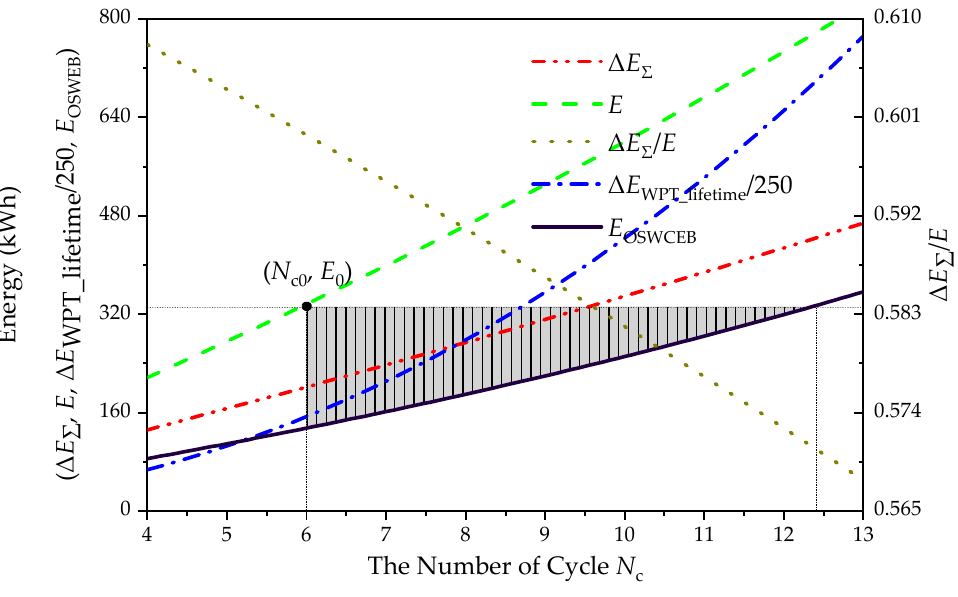
Figure 8. The effects of the number of cycles. Figure 8. The e ff ects of the number of